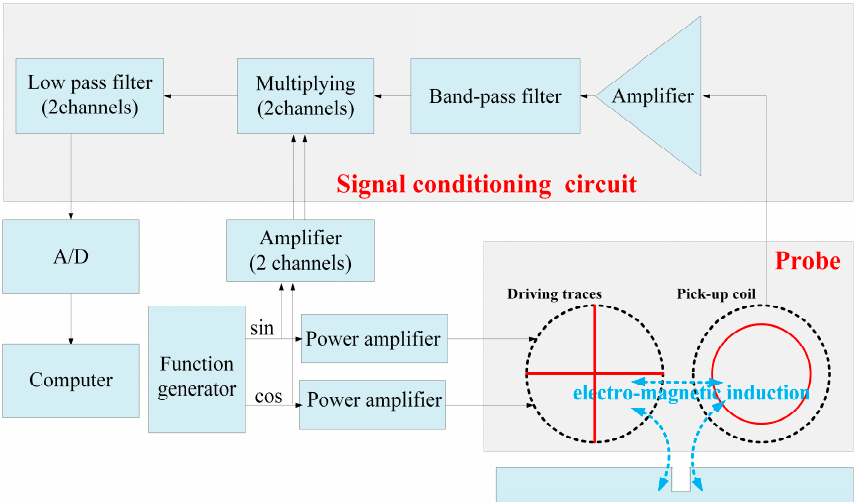
Figure 4. The schematic diagram for experimental system.